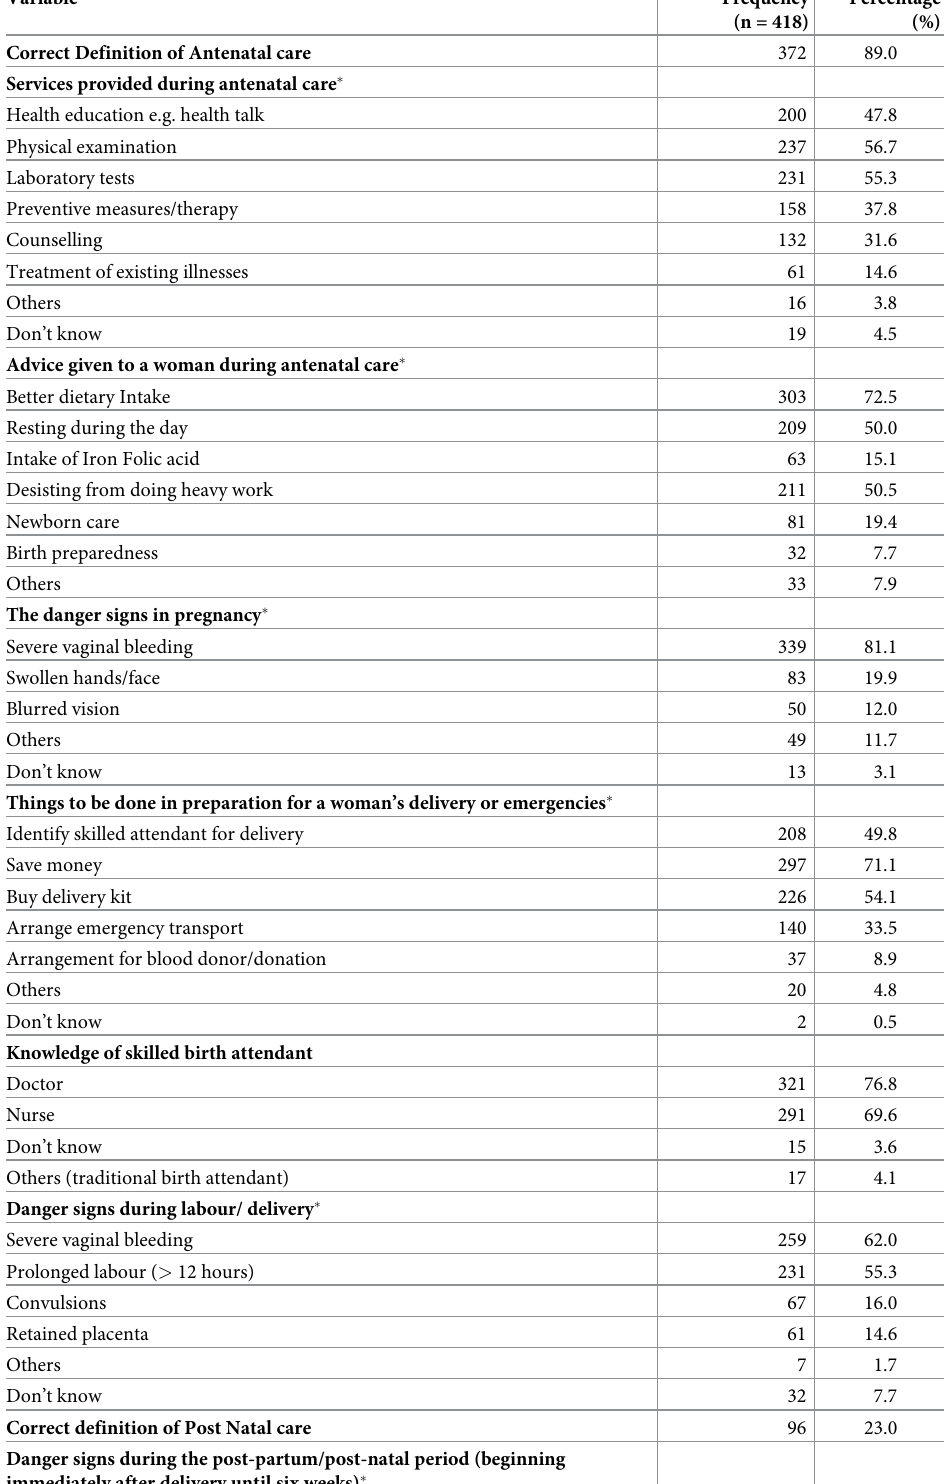
Table 3. Respondents knowledge of maternity